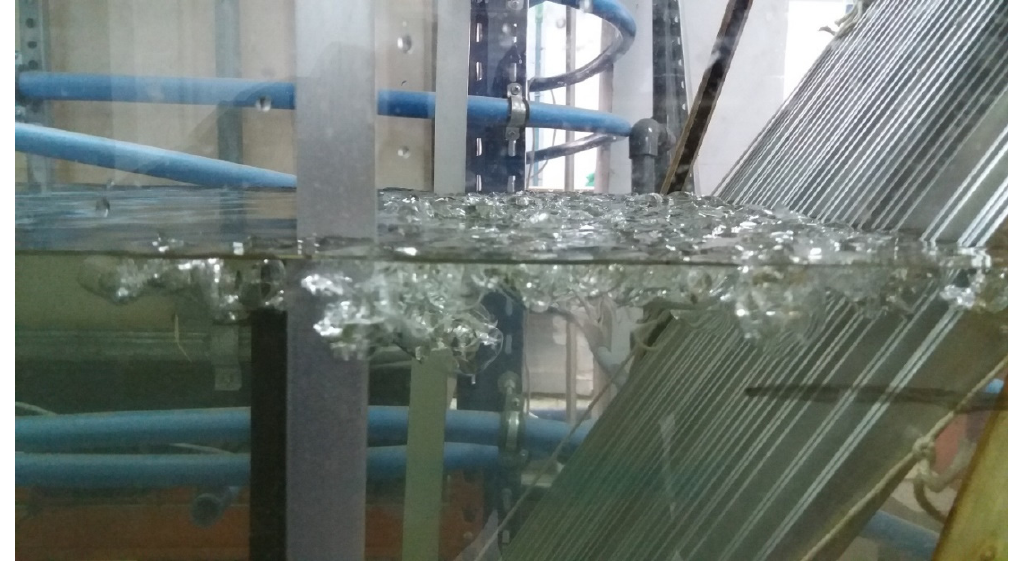
Figure 5. Ice jam, 1.6 kg ice variant.